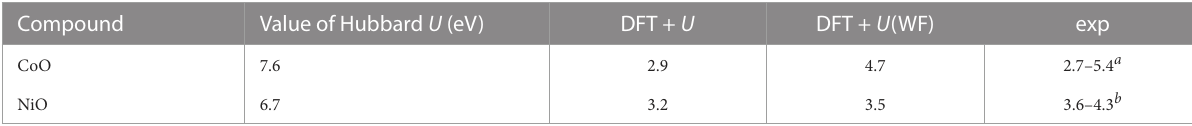
TABLE1 TheHubbard U parameterandthebandgapvalues(directbandgap)ofCoOandNiOcompoundscomputedwithdifferentmethods,and measured.WenotethatforthetwocompoundsweobtainedthesameHubbard U parametervalueswithbothconsidered d orbitalsprojectortypes. Compound